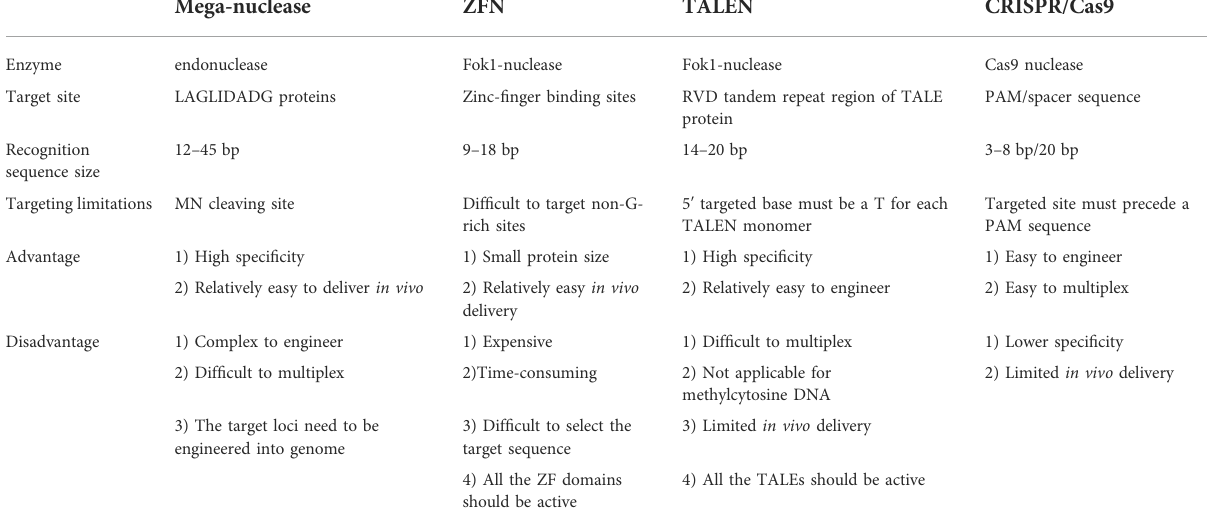
TABLE 1 The comparison of nuclease-mediated